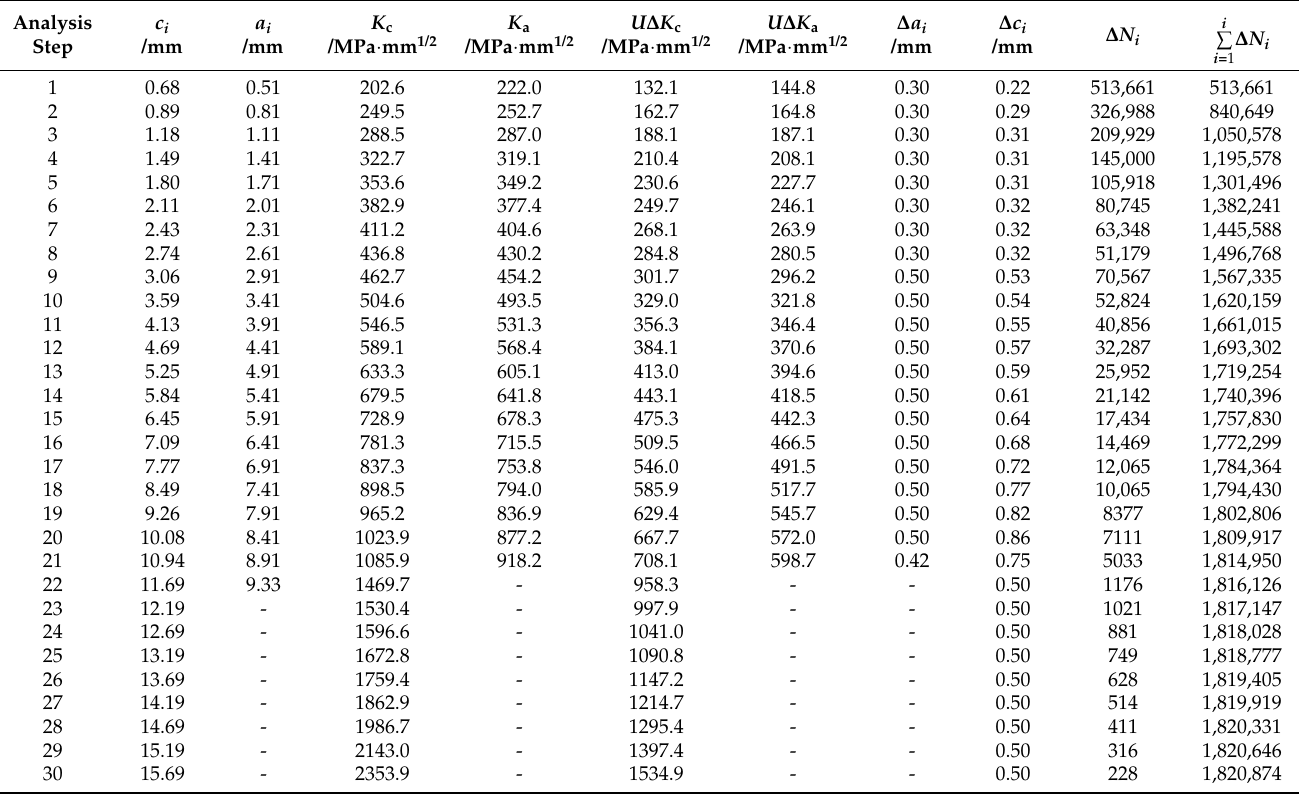
Table 3. The whole process of the fatigue crack propagation prediction of specimen C9-DS1-A.